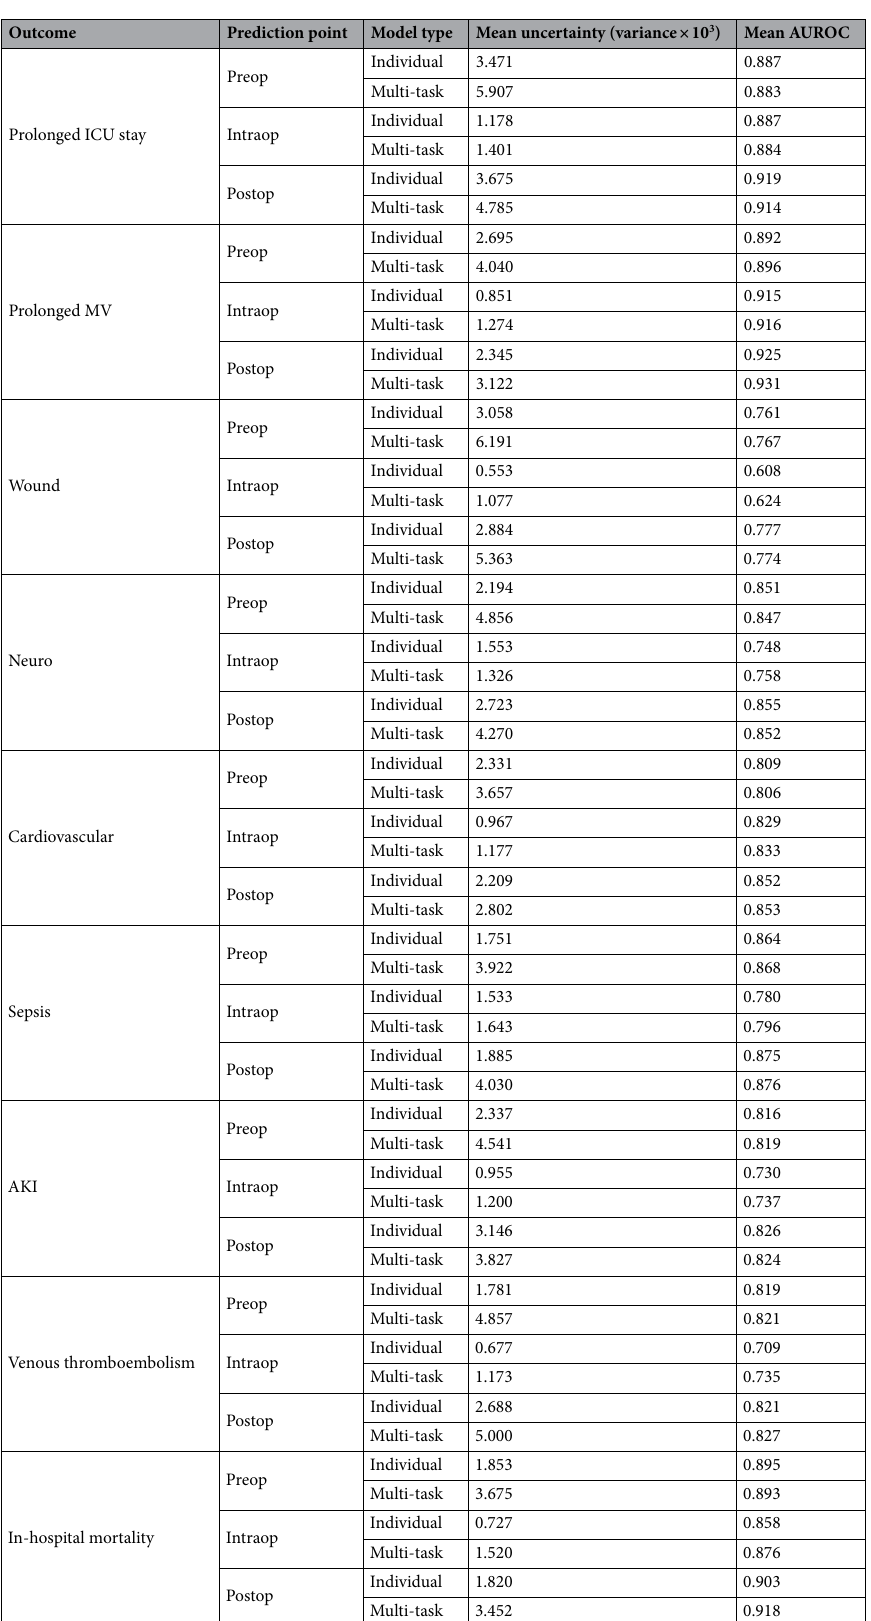
Table 2. Deep model uncertainty metrics aggregated over 100 Monte Carlo dropout